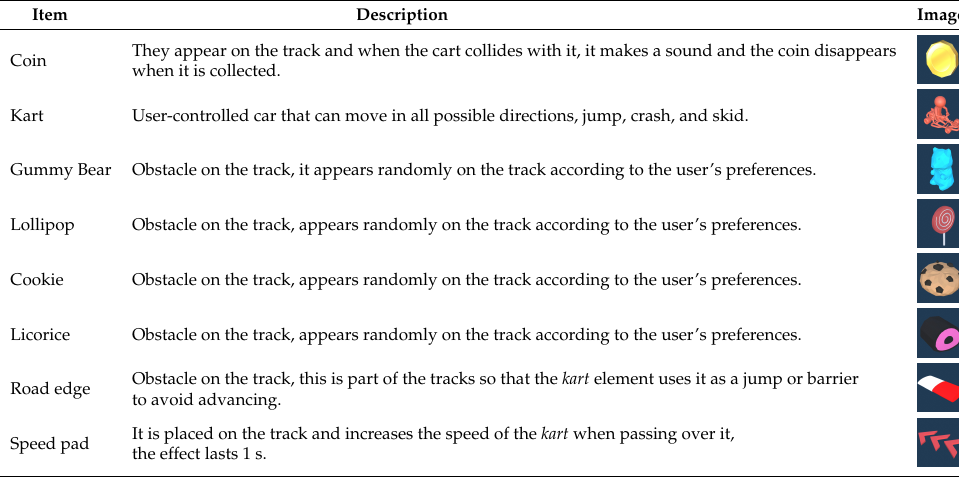
Table 1. Description of interactive elements related to the virtual